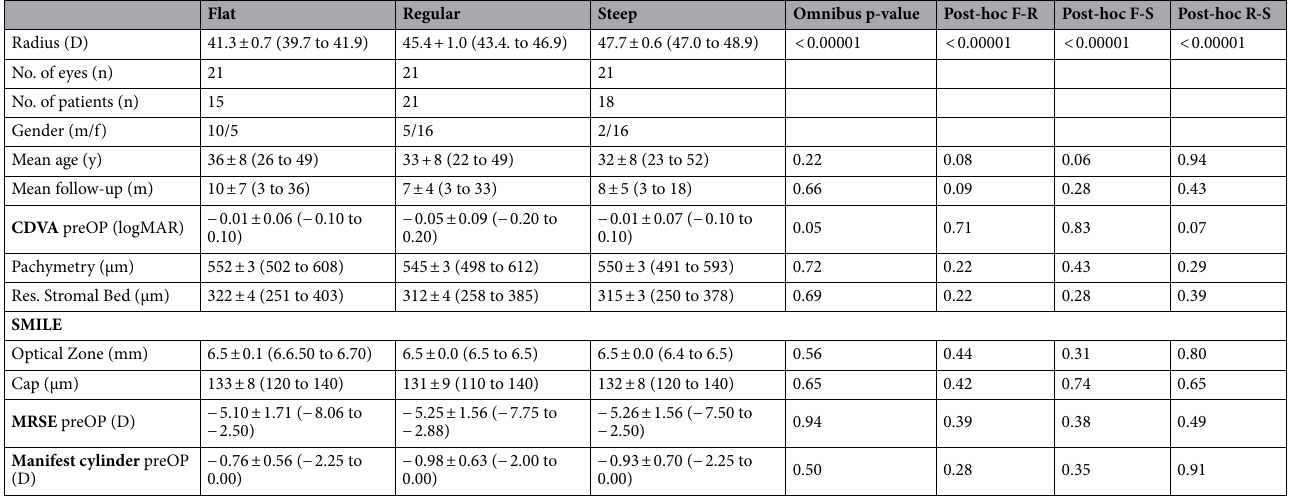
Table 1. Baseline parameters of the patient